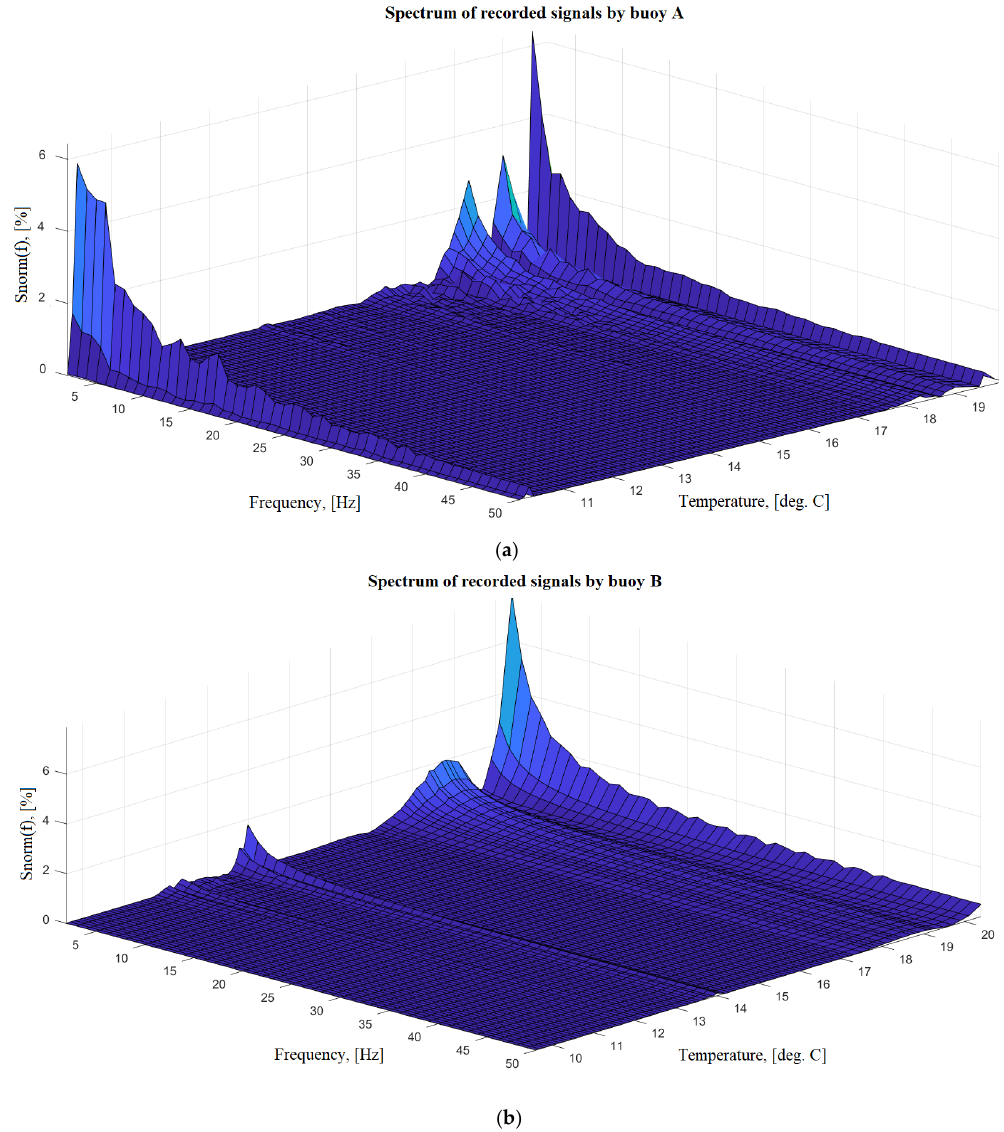
Figure 6. Changes in the spectral composition of the recorded signals by buoys A ( a ) and B ( b ) depending on the internal temperature.